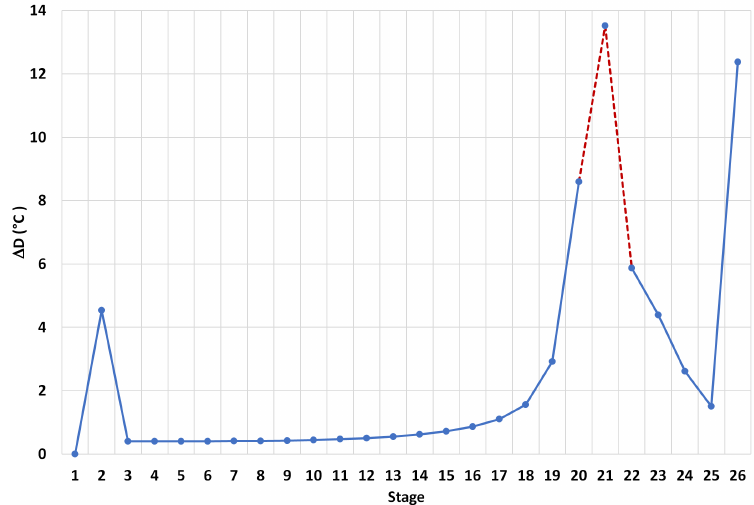
Figure 6. Analysis of the temperature change, stage to stage. Maximum slope criterion.